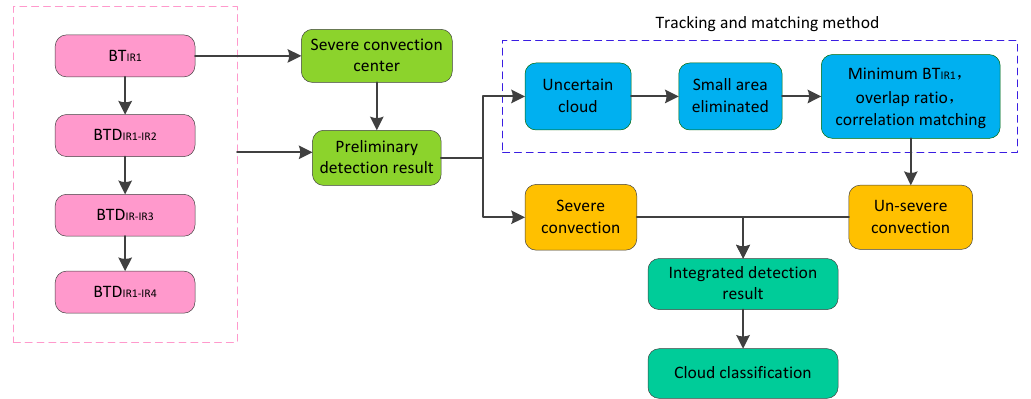
Figure 5. Convective cloud detection process. The detection process goes from the BT threshold method and ends with cloud classification.